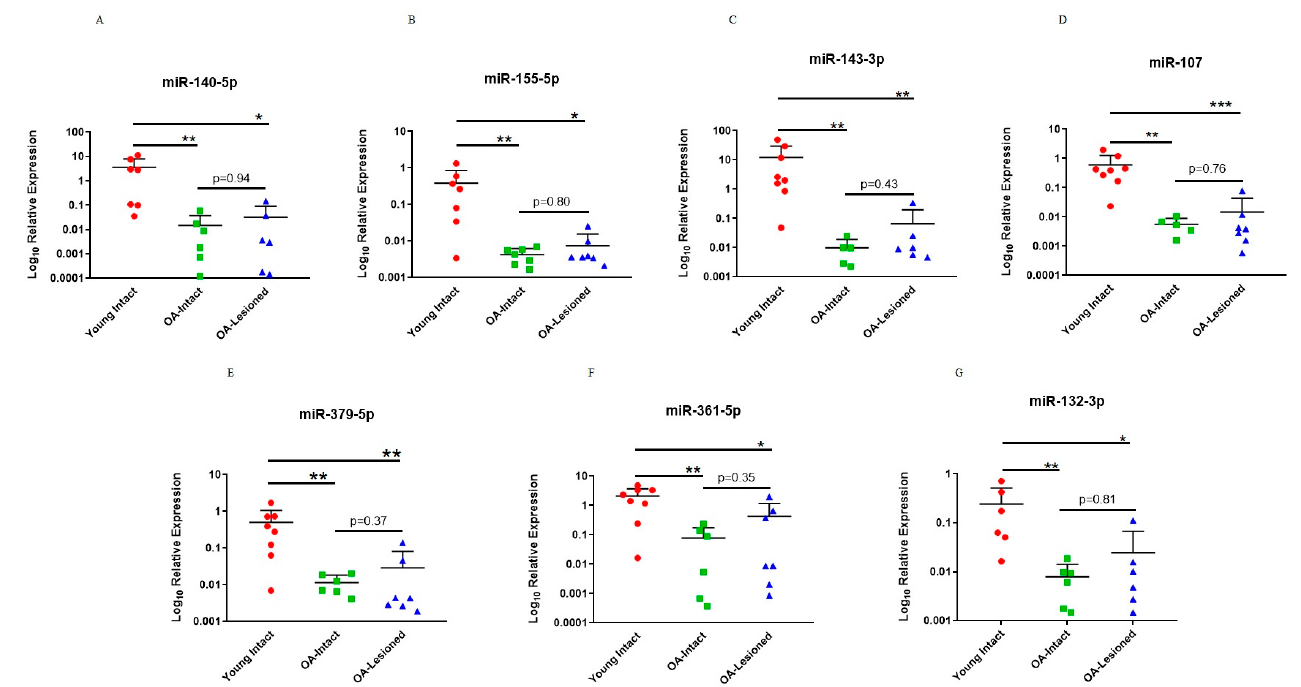
Figure 4. qPCR validation of selected DE miRNAs in the independent cohort. Seven miRNAs; ( A ) miR-140-5p, ( B ) miR-155-5p, ( C ) miR-143-3p, ( D ) miR-107, ( E ) miR-379-5p, ( F ) miR-361-5p and ( G ) miR-132-3p which were DE in microarray analysis were selected for validation with qPCR in an independent cohort of cartilage samples. n = 5–10 samples/group. Y axis represents log-transformed expression relative to miR-6786-5p. Statistical analysis was undertaken using a Mann–Whitney test in GraphPad Prism (Version 8.0.1). Data are represented as mean + SD. Red: Young group, Green: OA-Intact group, Blue: OA-Lesioned group. p values < 0.05 were considered significant. *: p < 0.05, **: p < 0.01, ***: p < 0.001.